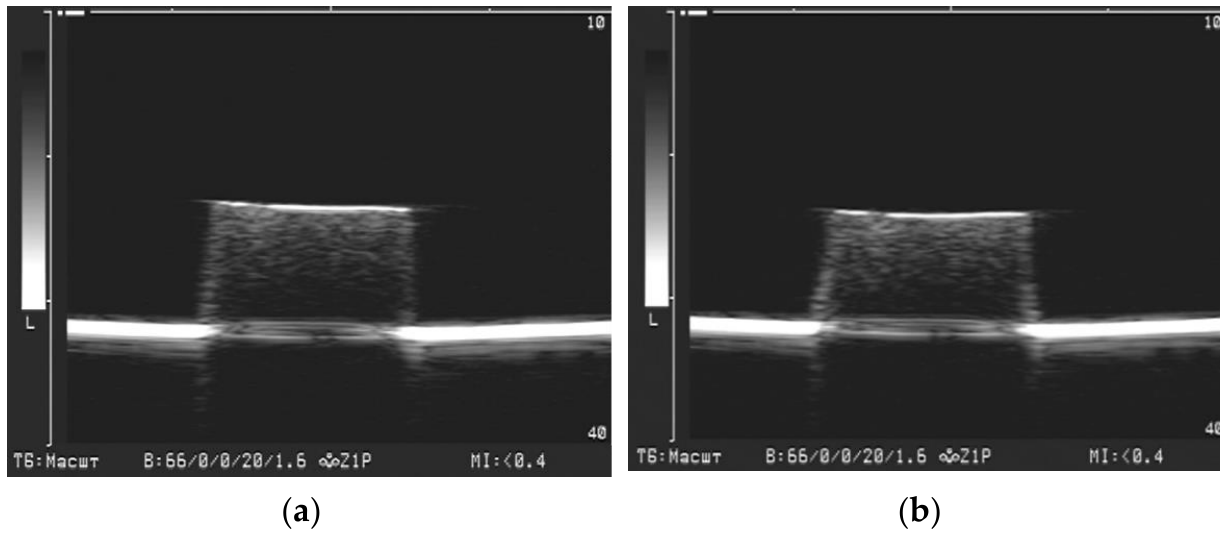
Figure 12. Ultrasound visualization of ferrogel deformation in applied magnetic field. FG with PAAm/Guar network and 23.3% content of iron oxide. ( a ) no field; ( b ) 400 Oe gradient field applied.